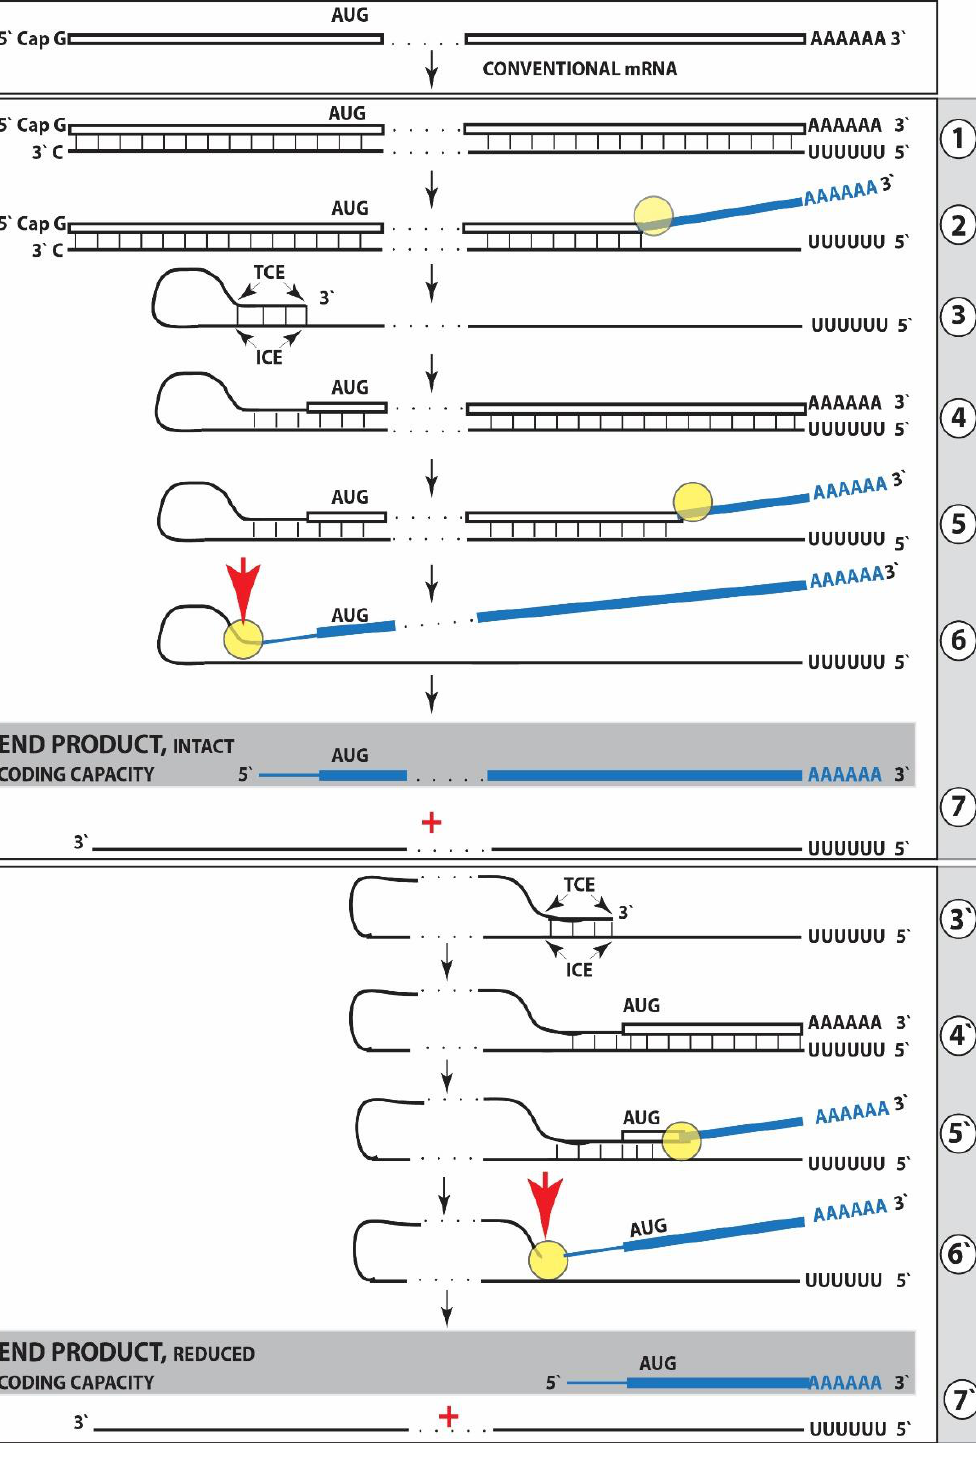
Figure 1. RdRp- mediated amplification of mRNA can result in a 5′ -truncated molecule encoding C- terminal fragment of a conventional polypeptide. Boxed line — sense strand RNA. Single line